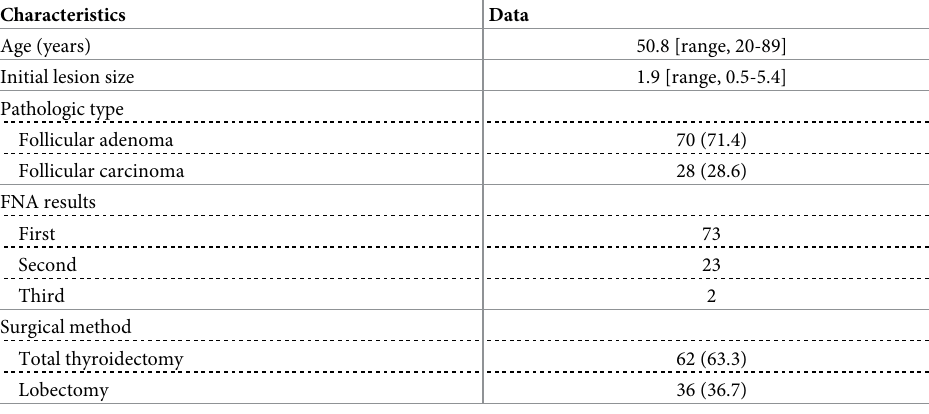
Table 1. Clinicodemographic patient characteristics (n = 98).